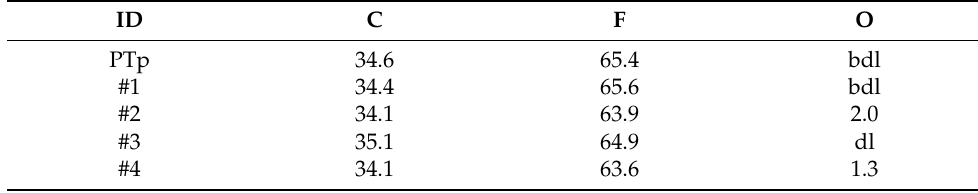
Table 2. Atomic percentage from XPS measurements on PTFE particles (PTFE-B-200, denoted as PTp) and cryo-XPS data after exposure of PTFE-B-200 to the solutions characterized in Table 3. In the table, “bdl” means below detection limit, and “dl” means at detection limit (~0.1 atom %).